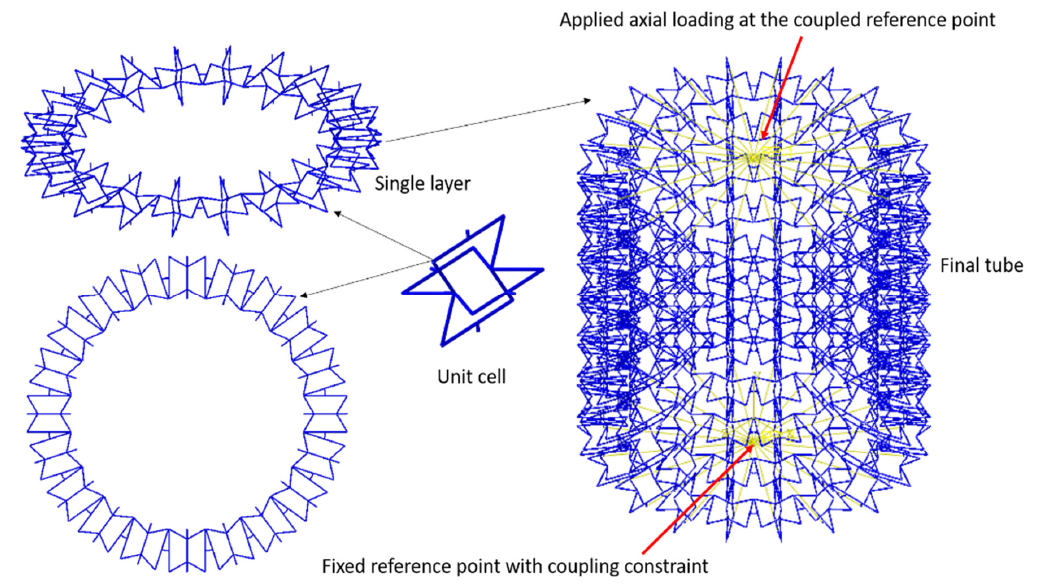
Figure 3. The geometry of a unit cell, single layer, and cellular tube used for FE model.